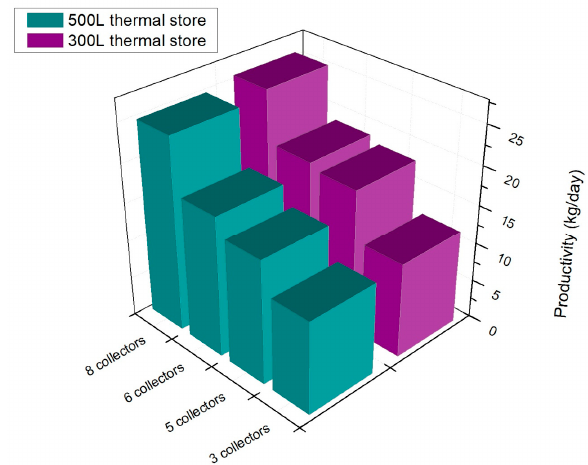
Figure 17. Distillate productivity with different collector area and storage volume.